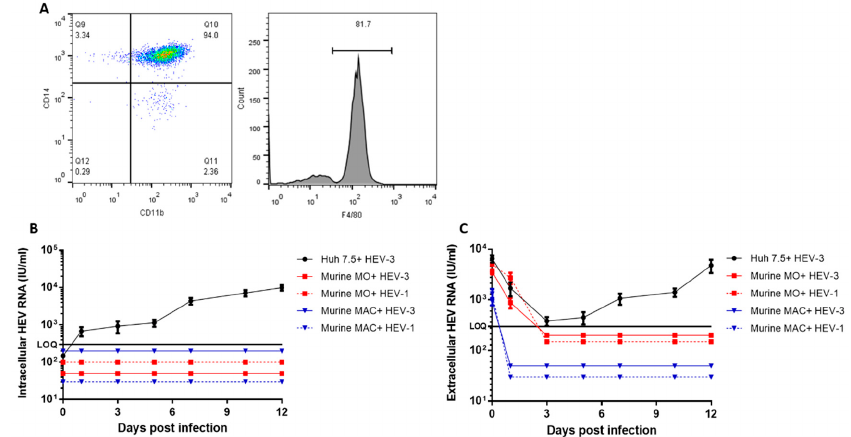
Figure 1. Characterization of murine monocytes and macrophages and infection with HEV inoculums ( A ) The isolated murine monocytes were analyzed by flow cytometry to check for purity, and isolated cells were stained with anti-CD14 and anti-CD11b (left). After differentiation into macrophages, the cells expressed a high level of F4/80 (right). Infection of murine monocytes (MMOs red) and murine macrophages (MMACs-blue) with HEV-1 (dotted line) and HEV-3 (solid line) inoculums. Intracellular HEV RNA ( B ) and extracellular HEV RNA ( C ) were quantified in the supernatants by qPCR. Huh7.5 (black) challenged with HEV-3 was used as a positive control. LOQ: limit of quantification. Depicted are the mean values of three independent experiments ±